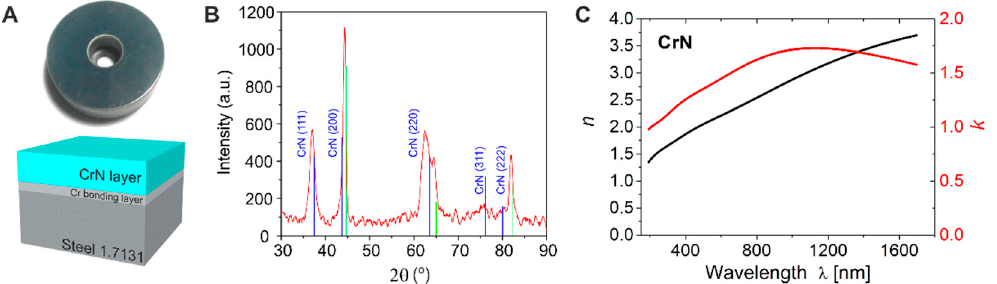
Figure 1. ( A ) Picture of the actual sample with a sketch that illustrates the steel 1.7131 substrate, covered with a 200 nm Cr film for bonding a 2.5 µm thick chromium nitride (CrN) top layer. ( B ) X-ray diffraction (XRD) data of a non-irradiated area of a CrN samples as displayed in ( A ), including peaks corresponding to iron (marked green) and a CrN form known as Carlsbergite (marked blue). ( C ) Plot of the refractive index n (left axis) and the extinction coefficient k (right axis) of the CrN layer for different wavelengths as measured by ellipsometry. In our calculations we used n = 2.439 and k = 1.623 for λ = 800 nm.